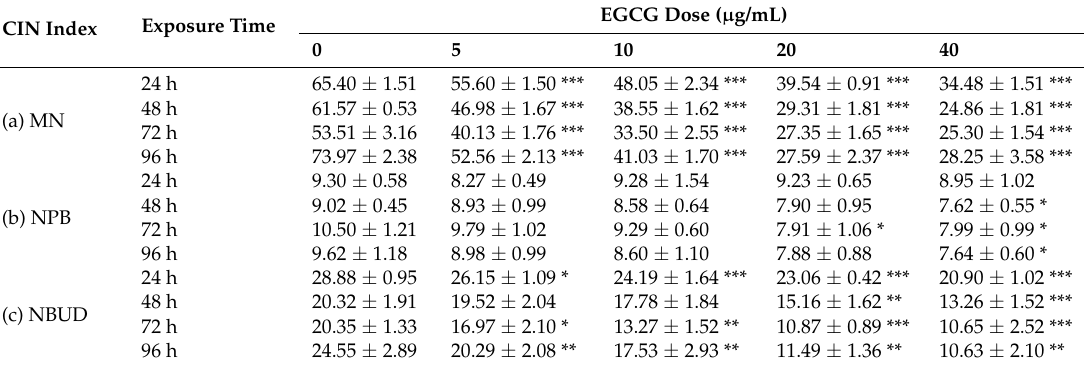
Table 1. The effects of EGCG on frequencies of CIN (MN, NPB, NBUD) in binucleated NCM460 cells.